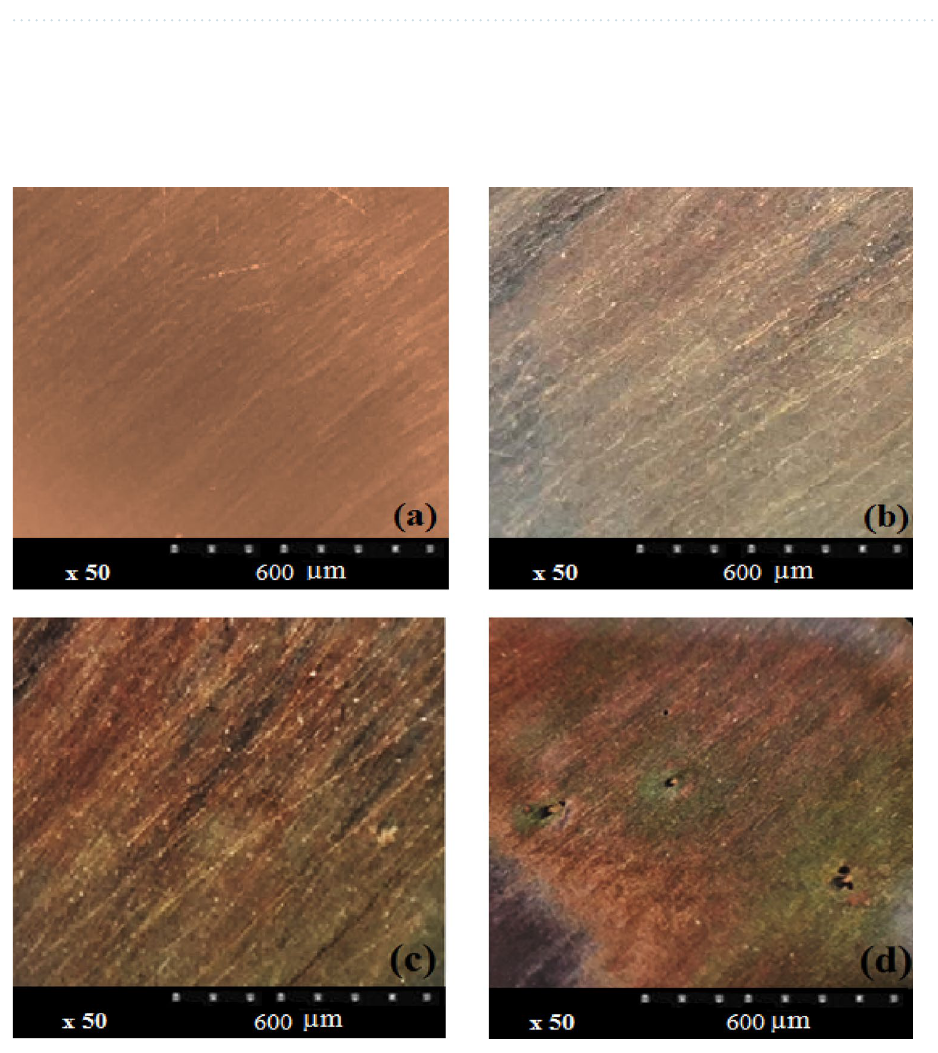
Figure 3. Optical micrographs of copper ( a ) before and ( b – d ) after immersion in 0.6 M NaCl, 0.6 M Na 2 SO 4 and 0.3 M NaCl + 0.3 M Na 2 SO 4 solutions at 60